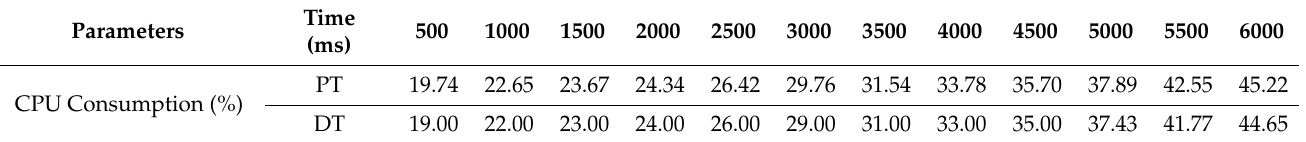
Table 4. Analysis of DT − PT Synchronization CPU consumption.